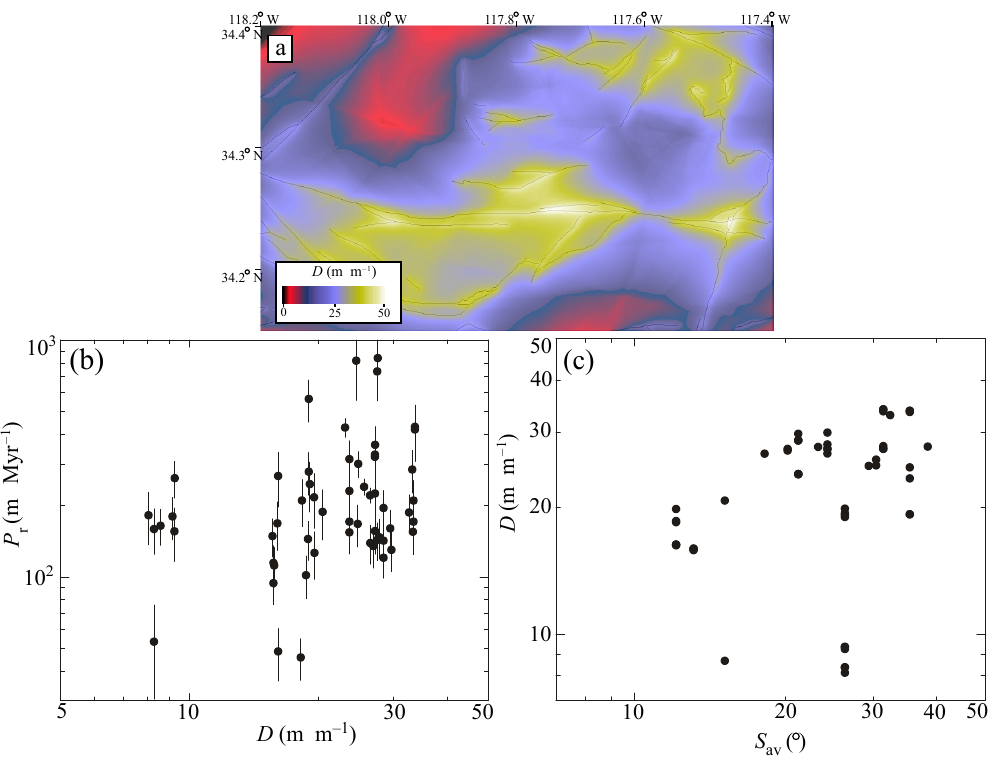
Figure 5. Map of the bedrock damage index, D , and its correlation with S av . (a) Color map of spatial variations D . (b) Plot of D versus S av for the 57 sample locations of Heimsath et al.